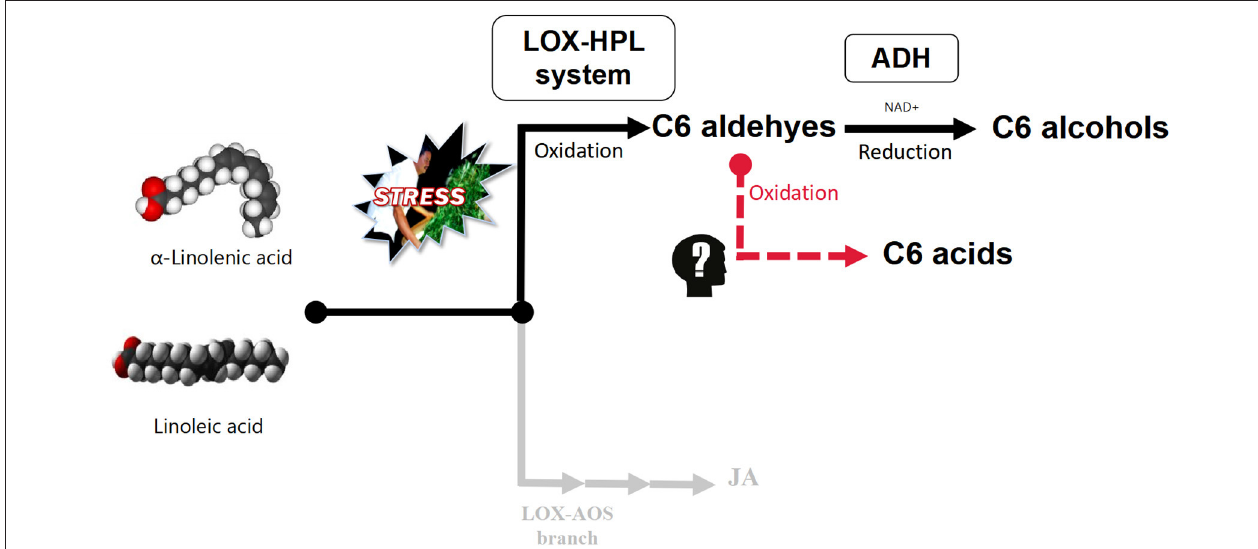
FIGURE 1 | LOX-HPL pathway for C6 compounds derived from long-chain unsaturated fatty acids. Long-chain unsaturated fatty acids (such as α -linolenic acid and linoleic acid) are the precursors of metabolic pathways. The enzyme system composed of LOX (lipoxygenase, EC1.13.11.12) and HPL (hydroperoxide lyase,